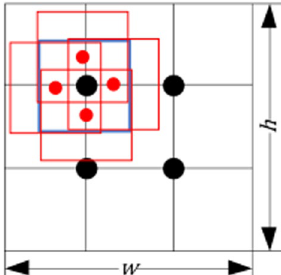
Fig. 9 Diagram of the initial hill-climbing